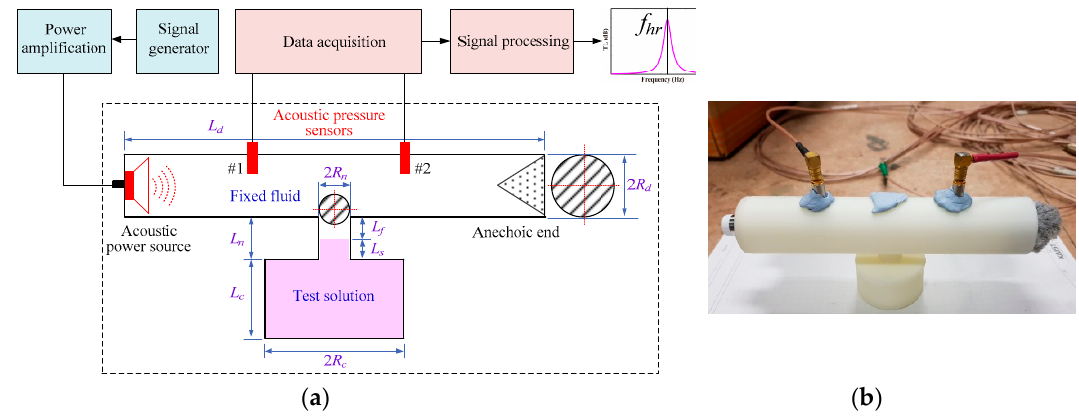
Figure 2. ( a ) Schematic illustration of analyte concentration measurement in the test solution; ( b ) Device architecture of the duct linked with a Helmholtz resonator .